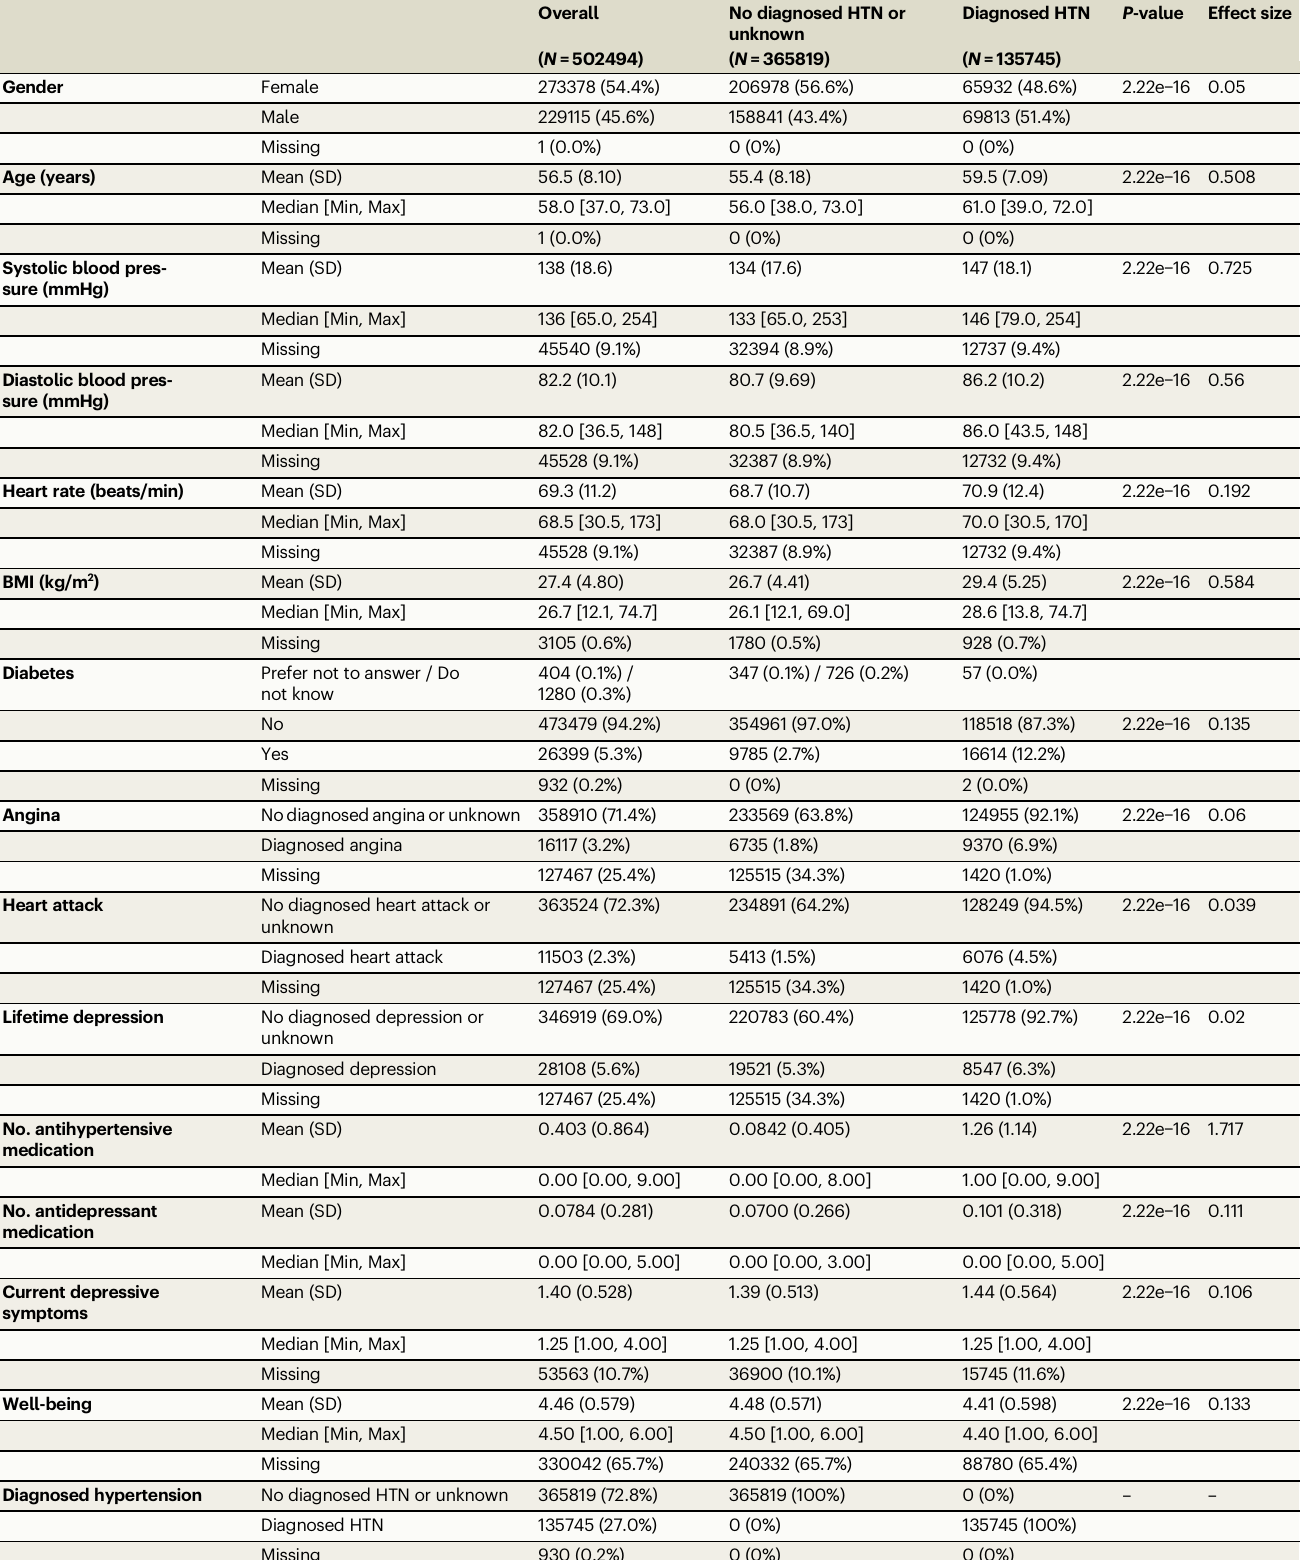
Table 1 | Sample characteristics at baseline assessment for total sample, as well as sub-groups with and without diagnosed hypertension